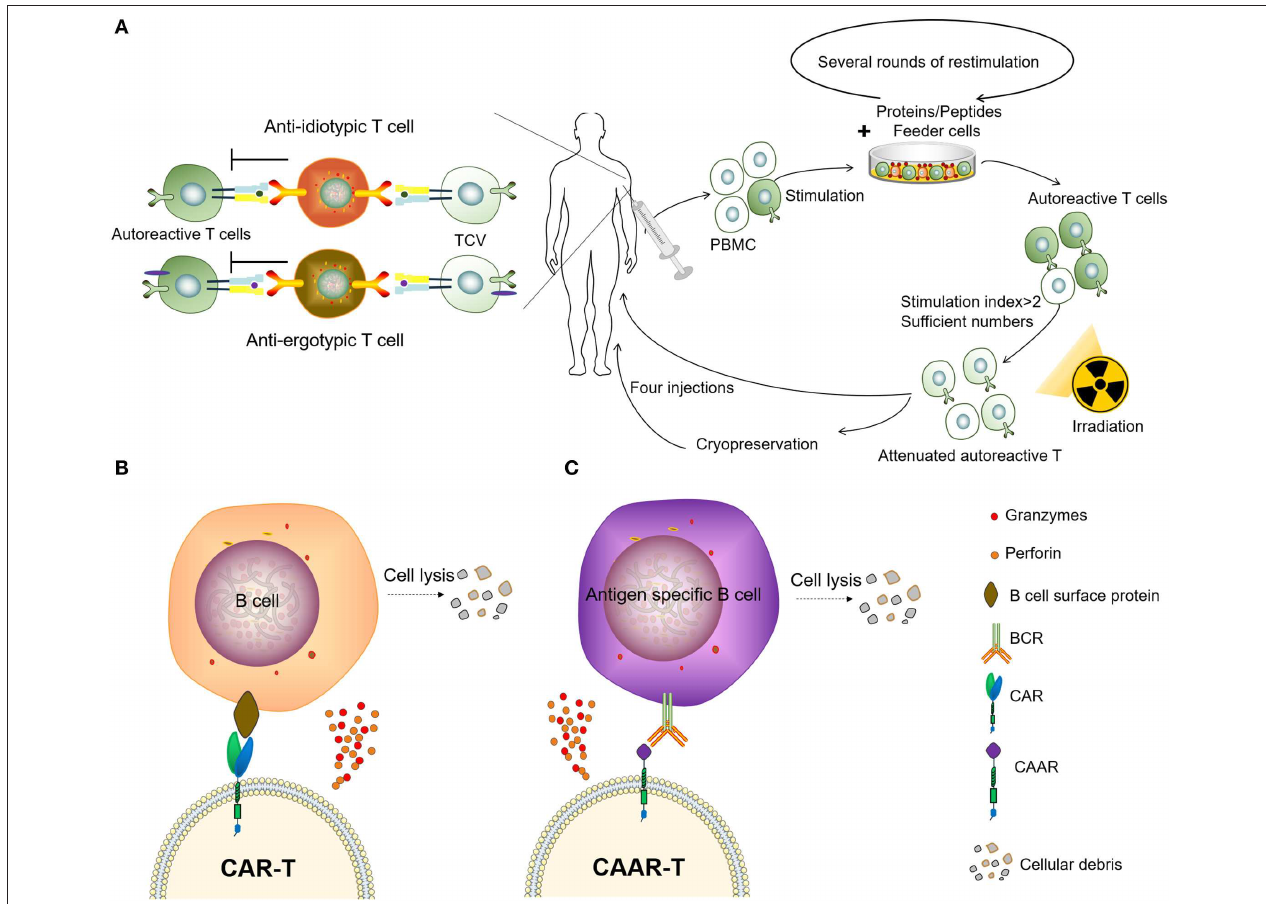
FIGURE 3 | Two types of adoptive immunotherapy to eliminate autoreactive immune cells. (A) Patients receive TCV. (B) Chimeric antigen receptor T (CAR-T) cells targeting B-lineage antigens to kill all B cells. (C) Autoantigen-based chimeric immunoreceptors direct T cells to kill autoreactive B lymphocytes through the specificity of the B cell receptor